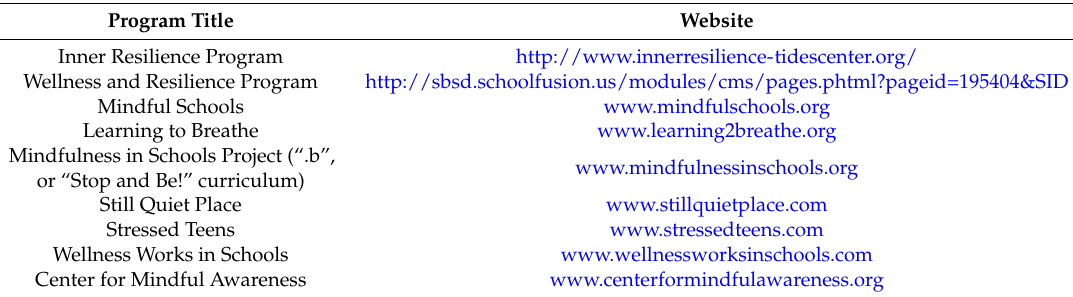
Table 3. Examples of structured mindfulness programs for